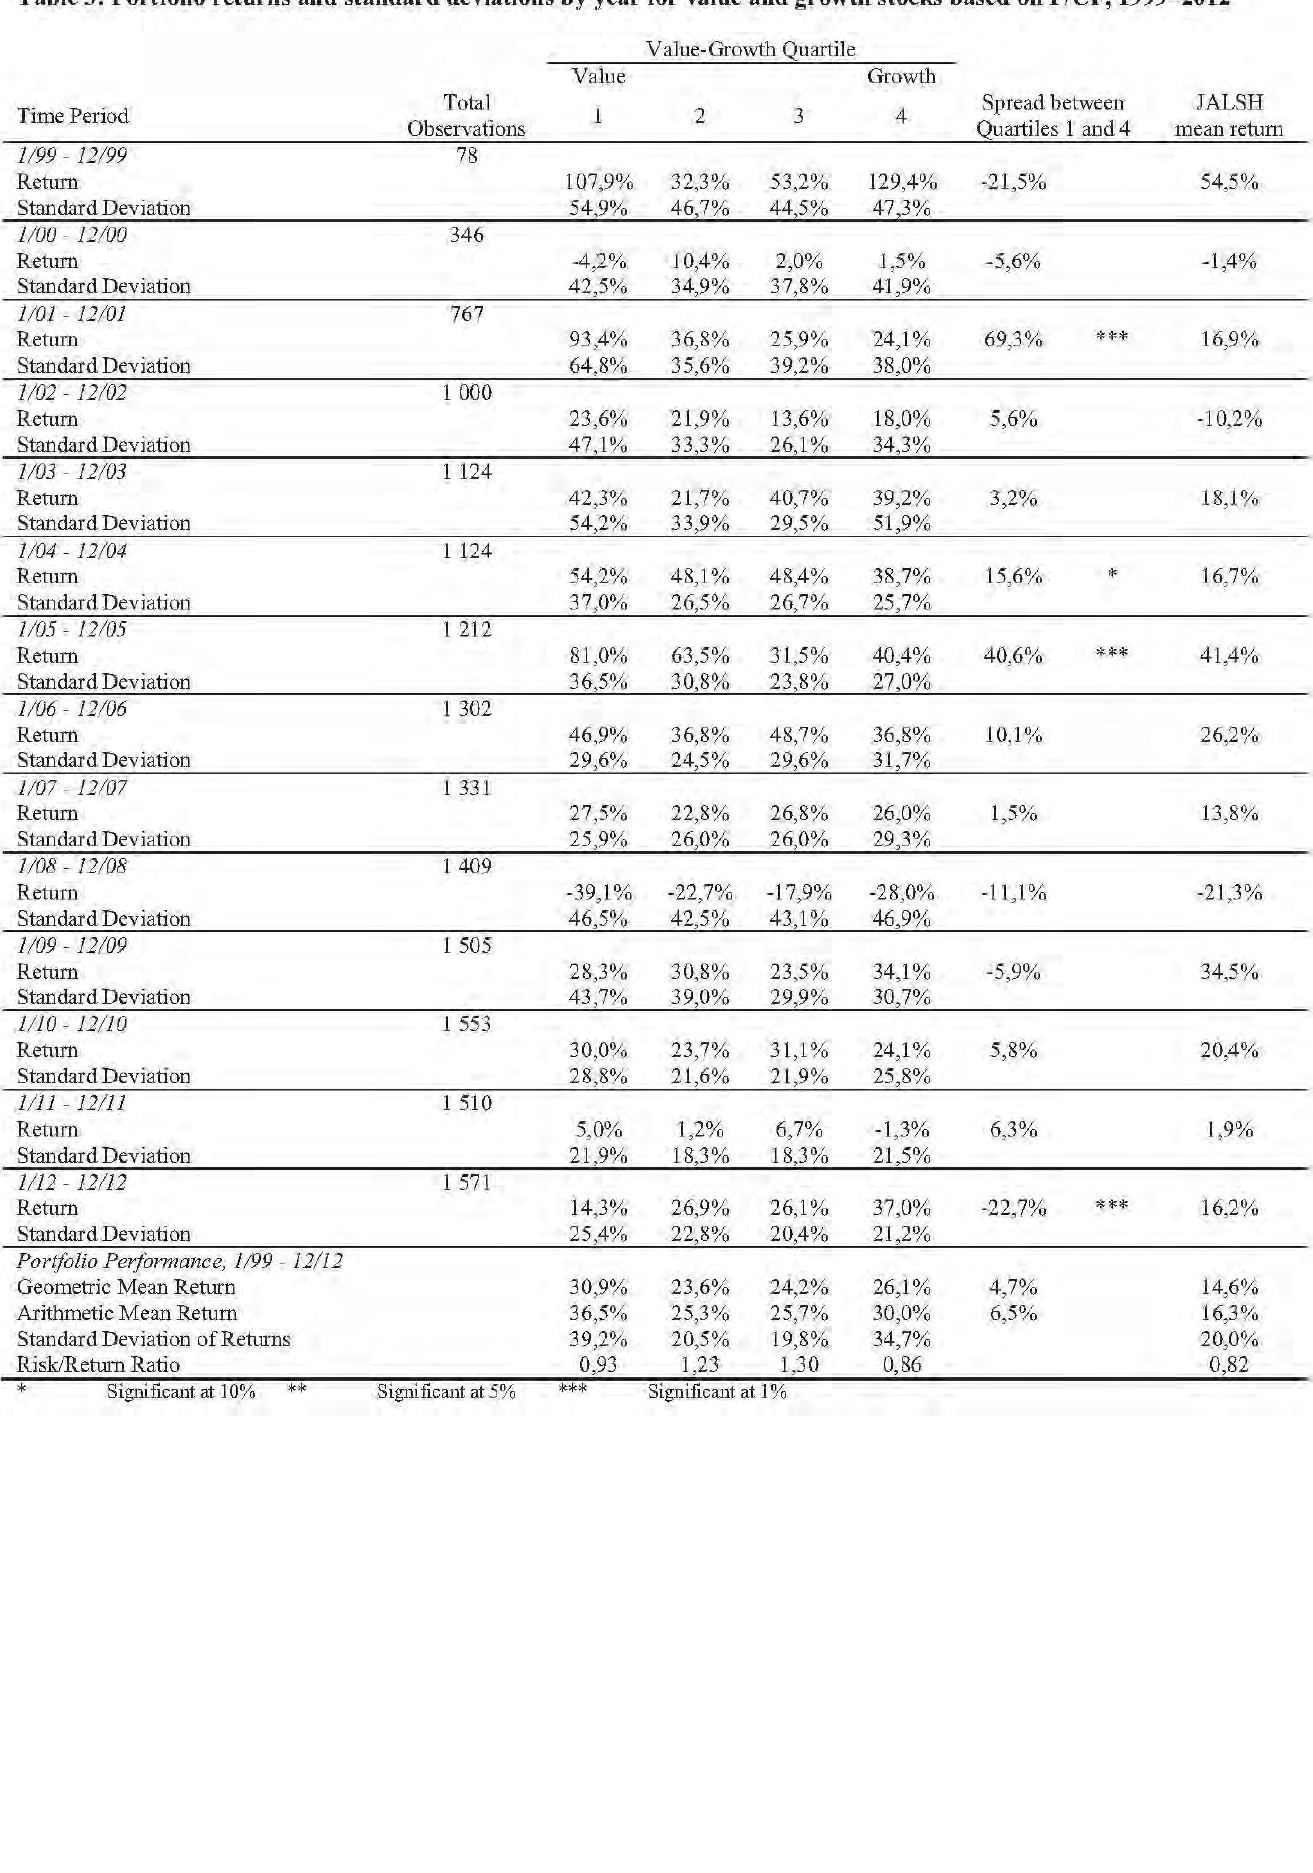
Table 3: Portfolio returns and standard deviations by year for value and growth stocks based on P/CF,